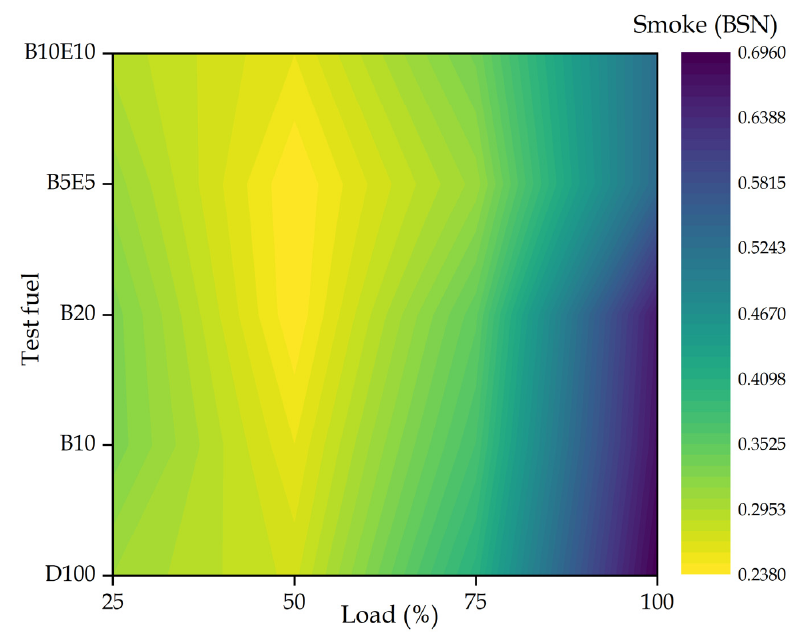
Figure 13. Variation in the smoke emissions of tested fuel blends against engine load.